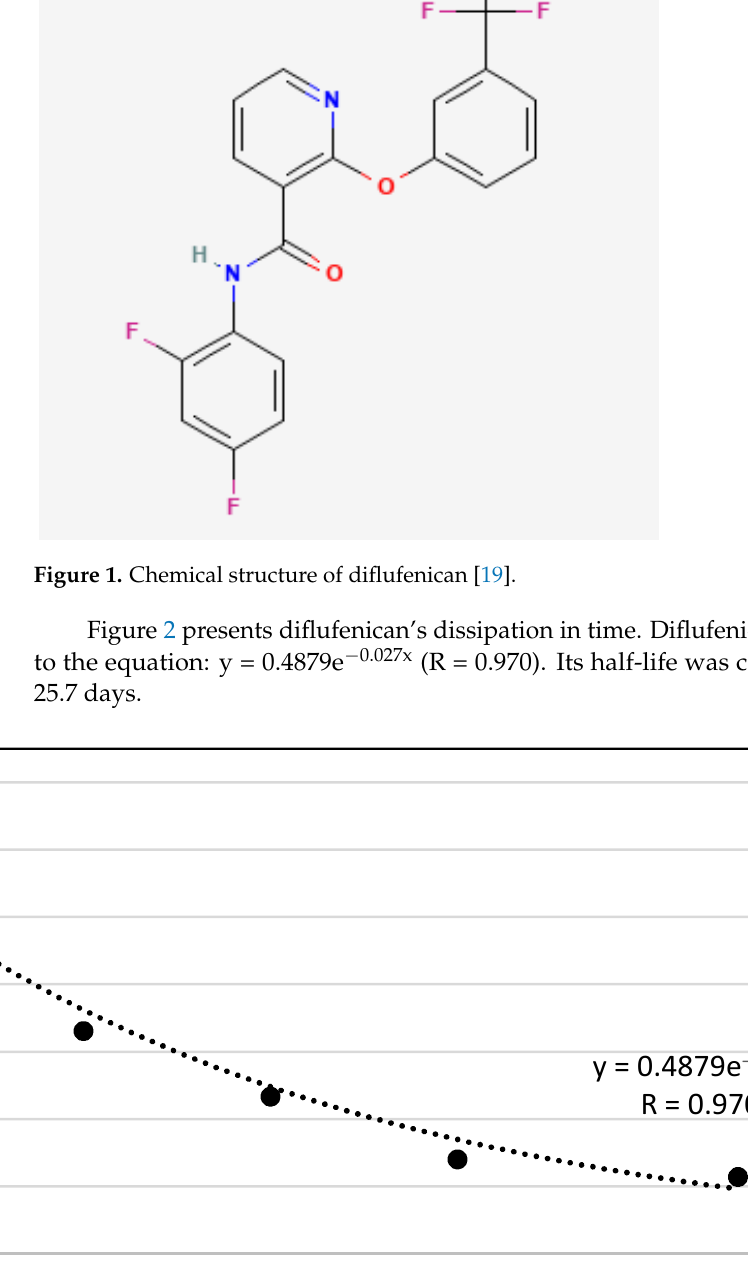
Figure 1. Chemical structure of diflufenican [19].